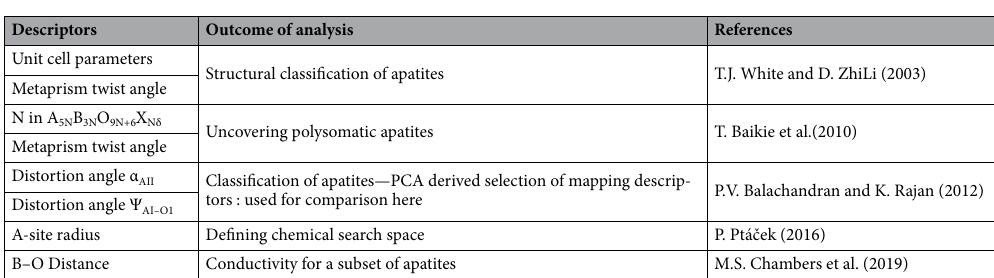
Table 2. Prior classifications of apatite or apatite-like (i.e. polysomatic apatites) compounds 16,22–25 . These descriptors represent the crystallographic characteristics of the apatite which have been identified as most closely determining the property of the compound.